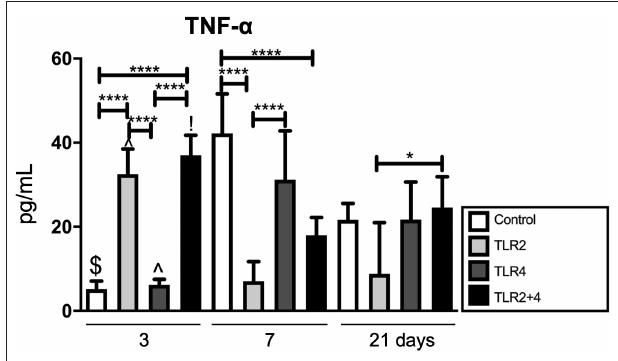
FIGURE 3 | TLR2 agonist has an evident effect on TNF- α ; increasing in early timepoints, reversed later. TNF- α is significantly elevated at day 3 in all conditions containing TLR2 agonist (light gray and black); at day 7, these conditions are significantly decreased in comparison with the control. At day 21, the are no differences anymore between TLR conditions and control. n = 6 GF cultures per condition in duplicates, average results ± SD are shown. Significant results are shown (black bars). * p < 0.05, **** p < 0.001, $ p < 0.01 for the same condition between day 3 and day 7, day 3 and day 21 as well as day 7 and day 21, ∧ p < 0.001 for the same condition between day 3 and day 7, as well as day 3 and day 21, ! p < 0.001 for the same condition between day 3 and day